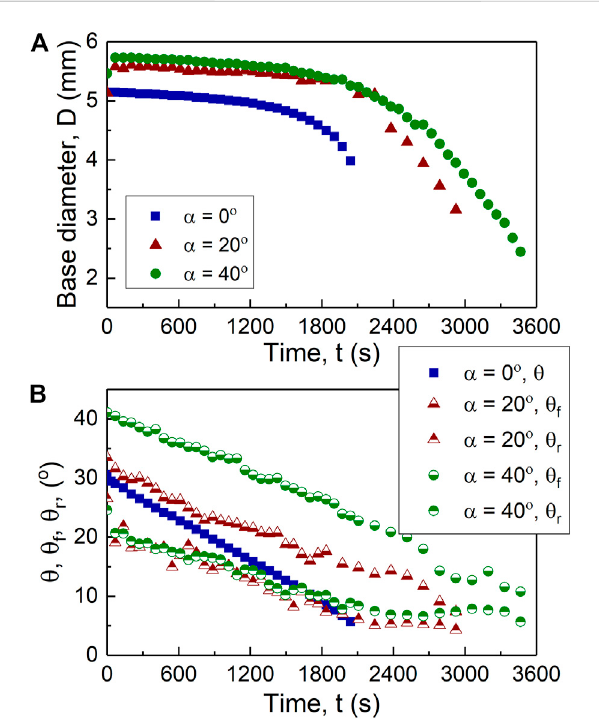
FIGURE 2 Temporal evolution of the drying 0.1% w/w microspheres drops at 0 ° , 20 ° , and 40 ° inclination: (A) base diameter, and (B) mean contact angle, θ , rear contact angle, θ r , and front contact angle, θ f .